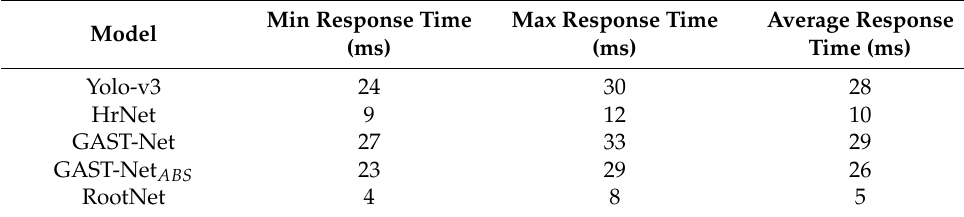
Table 6. Response time per model.